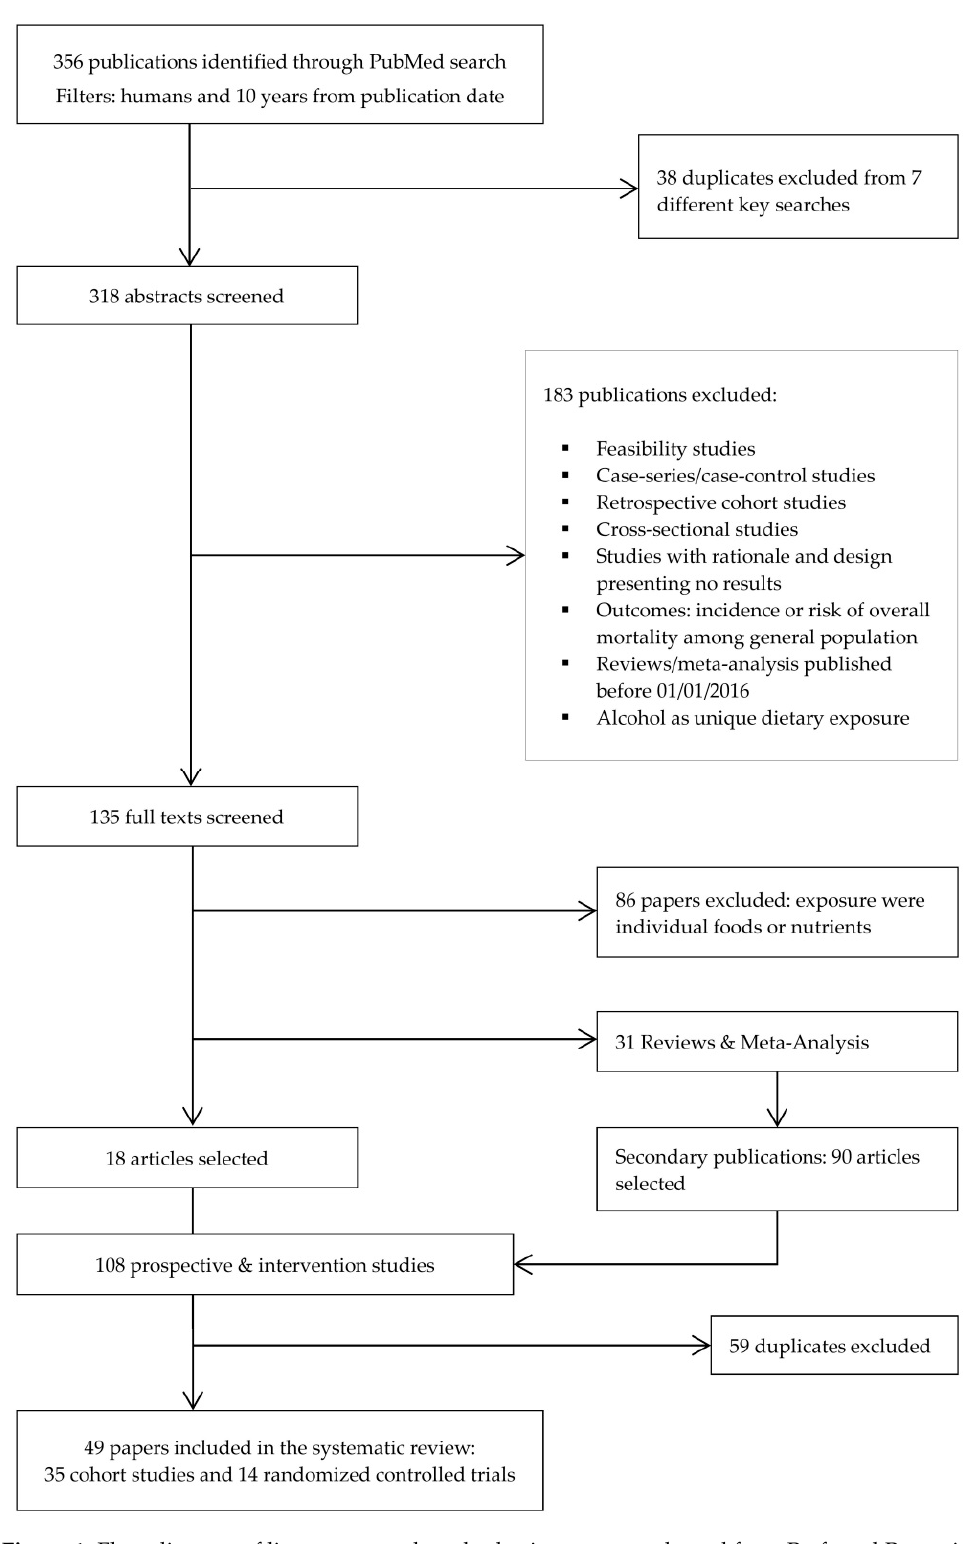
Figure 1. Flow diagram of literature search and selection process adapted from Preferred Reporting Items for Systematic Reviews and Meta-Analyses (PRISMA).